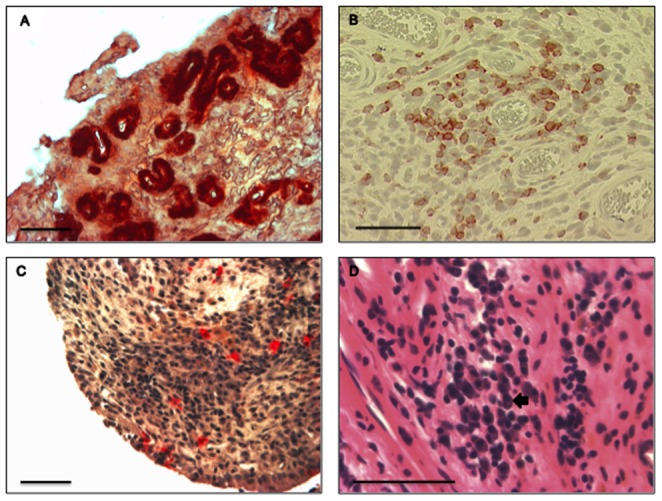
Stifle synovial biopsies from dogs with non-contact cranial cruciate rupture.(A) Factor VIII+ immunohistochemical staining of blood vessel endothelium. Blood vessel intima stains intensely red. (B) CD3 immunohistochemical staining of T lymphocytes. CD3+ cells exhibit red staining on the cell surface. Clusters of CD3+ T lymphocytes were typically arranged in characteristic aggregates around a blood vessel. (C) Histochemical staining for tartrate-resistant acid phosphatase (TRAP) as a marker for activated macrophages. TRAP+ macrophages stained intensely red and were often found throughout the synovium in association with other mononuclear cells. (D) Hematoxylin and eosin staining typically revealed the presence of a substantial population of mononuclear inflammatory cells within the synovium. Large numbers of plasma cells were typically seen. Plasma cells have a perinuclear clear zone (black arrowhead). A & B - 3-amino-9-ethylcarbazole chromogen, Mayer's hematoxylin counterstain; C - naphthol AS-BI/paraosanaline histochemical stain, Mayer's hematoxylin counterstain; D – hematoxylin & eosin stain. All scale bars are 50 µm.